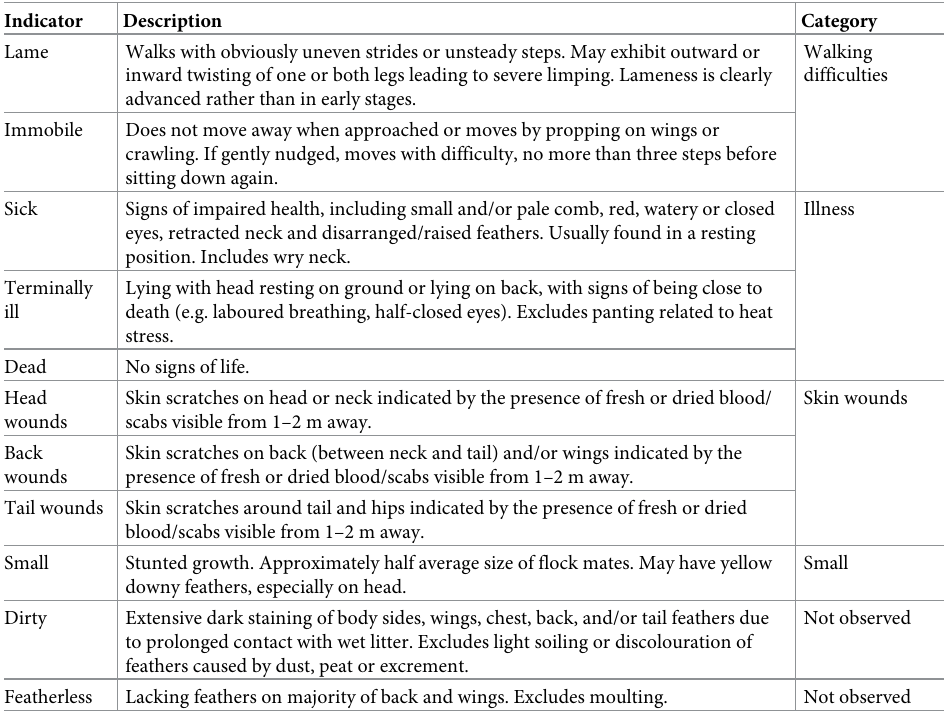
Table 2. Ethogram of broiler welfare problems recorded during transect sampling, and subsequently pooled categories. Indicator